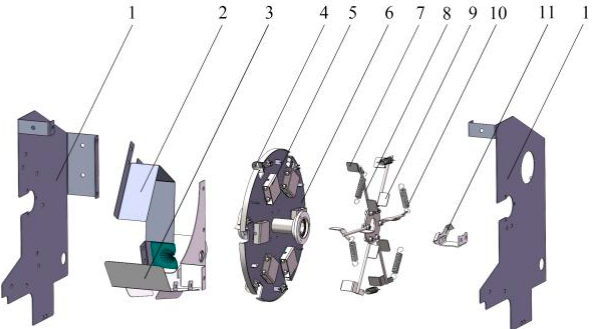
Figure 1. Schematic diagram of the seed-metering device: 1. the seed discharger side plate; 2. the intermediate partition; 3. the falling seed guide; 4. the seed-collecting spoon; 5. the seed extraction splint-fixing box; 6. the seeding tray; 7. the seed press plate; 8. the rotating shaft of seed pressers; 9. the control execution board; 10. the fine adjustment spring; 11. the seed-opening and -closing control board.